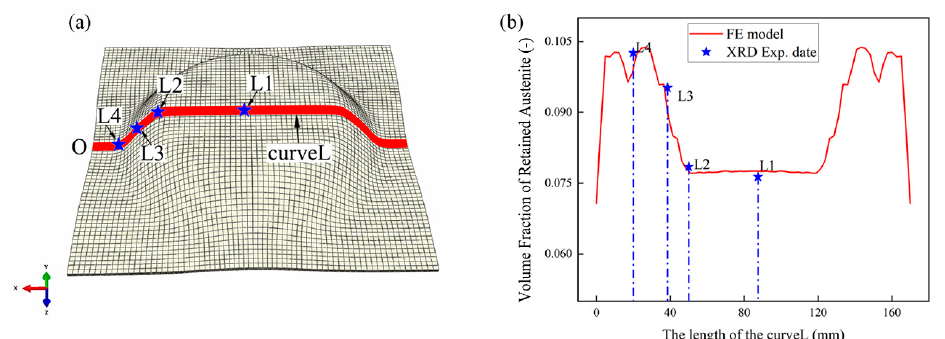
Figure 21. When the stroke of the punch reaches 25 mm, comparison between Marciniak test results and Prediction results of martensitic phase transformation by FE model: ( a ) schematic diagram of the location of XRD points; ( b ) the results of martensitic transformation predicted by FE model are compared with the experimental results.